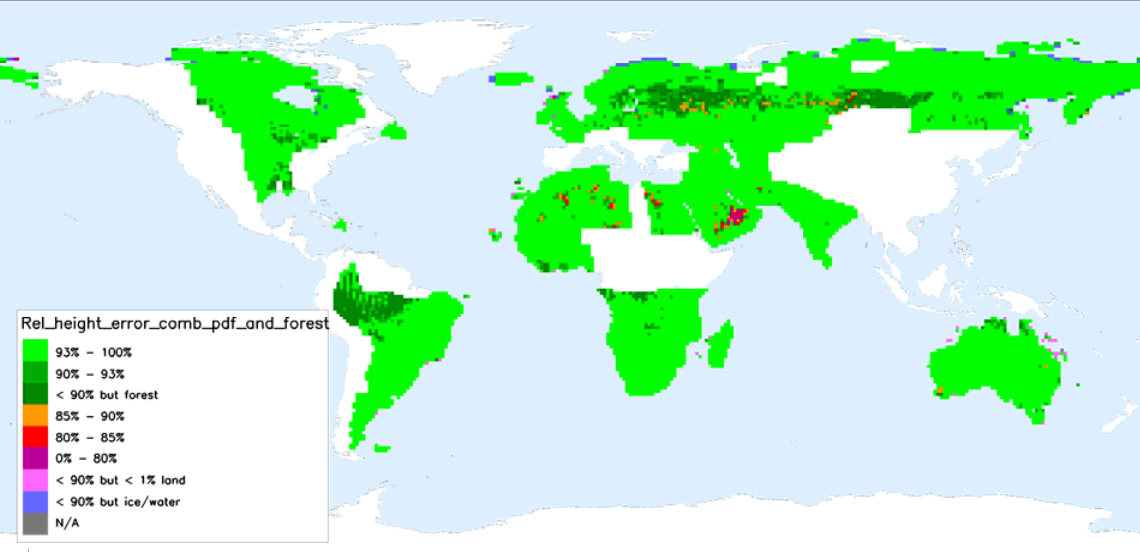
Figure 6. Global map showing confidence level for relative height accuracy (2 m for flat and 4 m for steep terrain) per DEM tile (status February 2015).